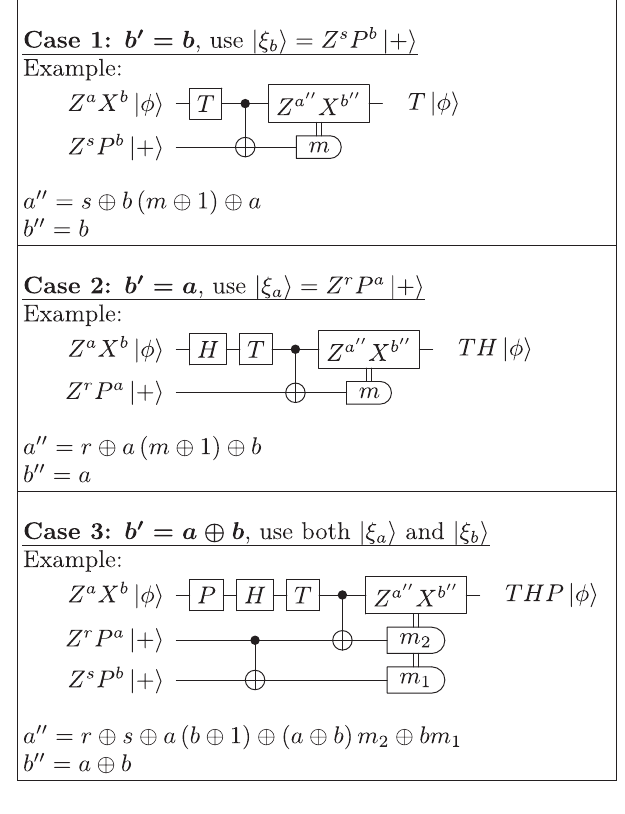
FIG. 2. The ancilla qubit(s) usage in three canonical cases for single-qubit Clifford sequences followed by a T gate. By a 0 and b 0 we denote the result of transforming decryption keys a and b in accordance with Fig. 1 for every Clifford operation that precedes the T gate (which here are the gate sequences T , TH , and THP ). Here, r; s ∈ f 0 ; 1 g are random bits that secure j ξ a i and j ξ b i ,